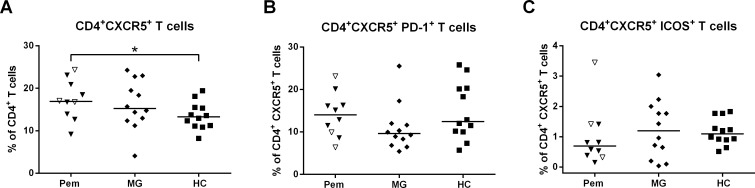
Elevated Tfh cells in pemphigus patients.(A) cTfh cells (defined as CD4+CXCR5+ T cells) were analyzed by flow cytometry in patients with pemphigus (Pem; n = 10), MG (n = 12) and HC (n = 12). (A) The frequency of cTfh cells was significantly increased in Pem patients while altered PD-1 (B) or ICOS (C) expression on cTfh cells could not be observed. Pem patients are categorized as remittent (open symbols) and active (filled symbols). Differences between the groups were analyzed using Mann-Whitney-U-Test with p values indicated as *p<0.05.